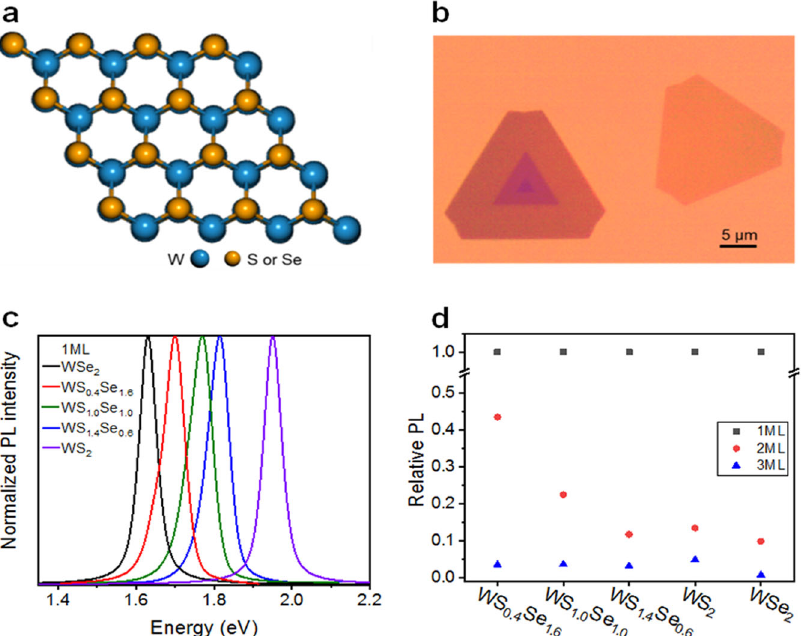
Fig. 1 Structural and electronic properties of the few layers WS 2(1 − x ) Se 2 x . a Schematic view of the atomic structure of WSSe. For clarity, only two superposed atomic sheets are displayed, in which the atoms in the top layer have been drawn slightly smaller than the ones in the bottom layer. b Typical optical image of the as-grown WS 2(1 − x ) Se 2 x fl akes on the SiO 2 /Si substrate. c Normalized PL spectra from monolayer